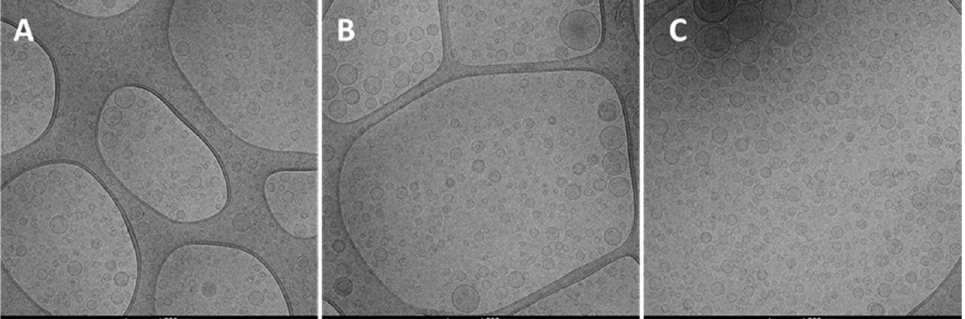
Figure 1. Representative Cryo-TEM images of 0.05% hyalurosomes loading 5 mg/mL of extract ( A ); 0.1% hyalurosomes loading 10 mg/mL of extract ( B ); and 0.1% hyalurosomes loading 20 mg/mL of extract ( C ).